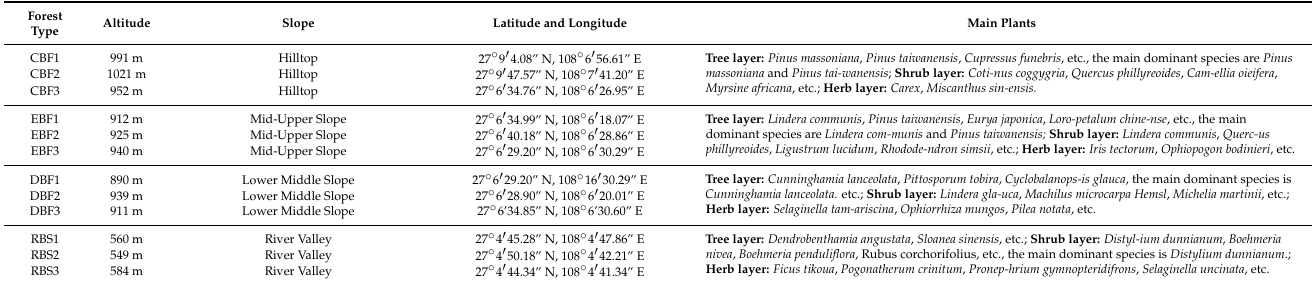
Table 1. Natural environmental characteristics of the study